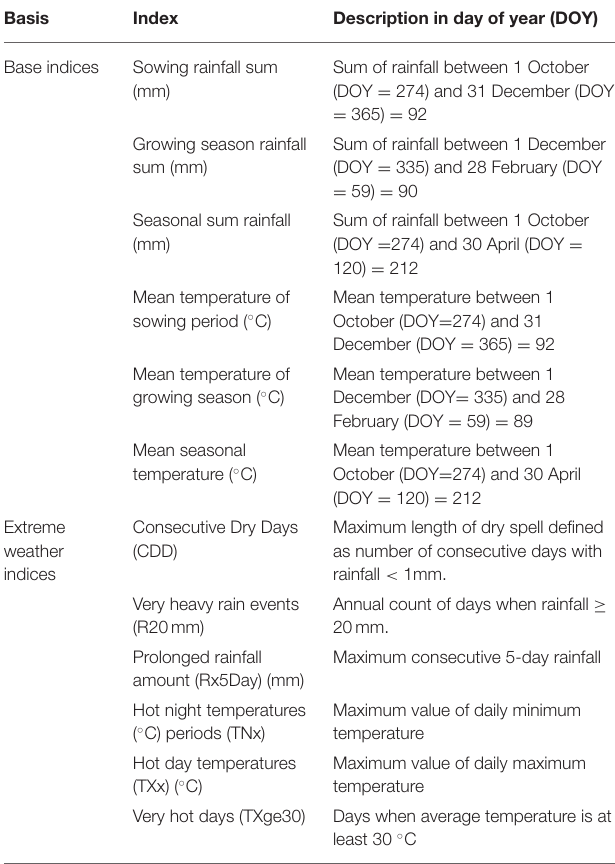
TABLE 1 | Indices used for maize crop suitability modeling and their descriptions and